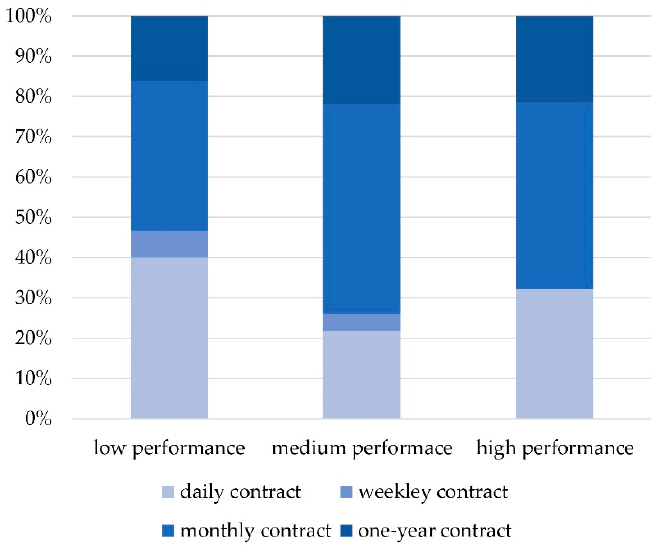
Figure 10. Most profitable contracts by performance category.